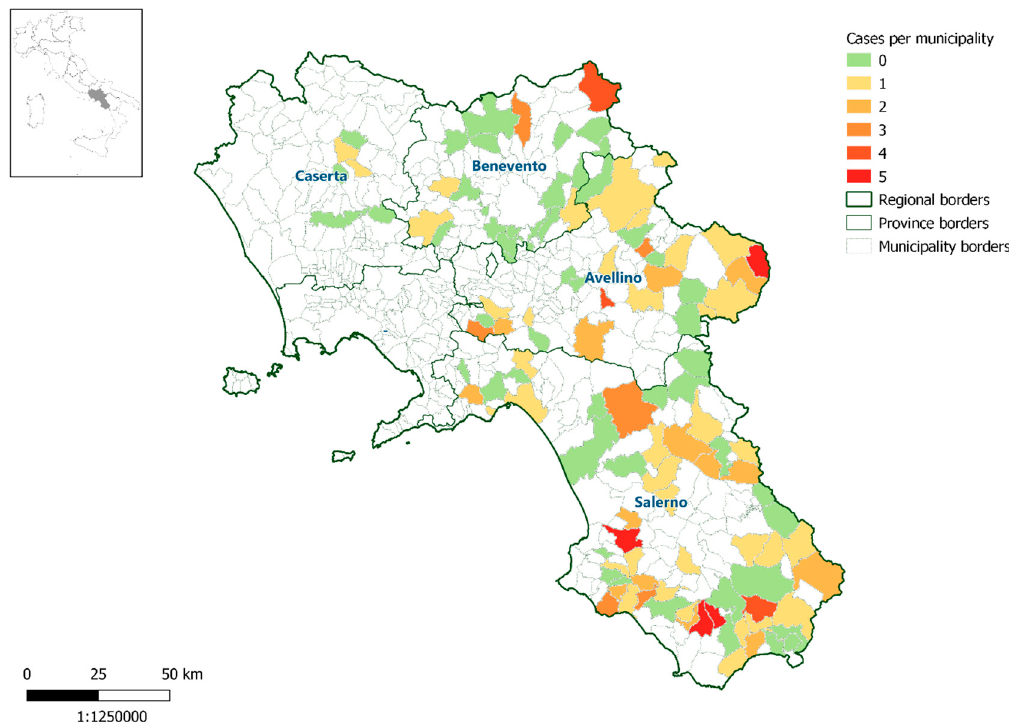
Figure 1. Map of the Campania Region (Italy) showing the distribution of samples of Eurasian wild boar ( Sus scrofa ) seropositive for Pseudorabies virus.